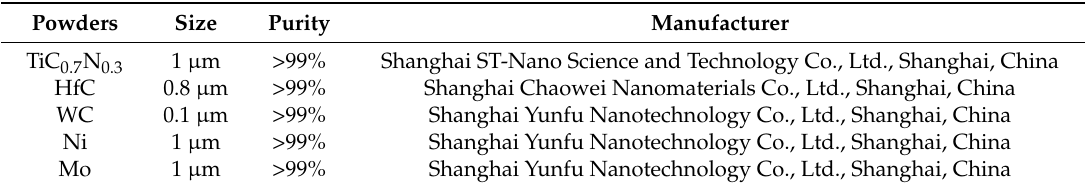
Table 2. Specifications of raw